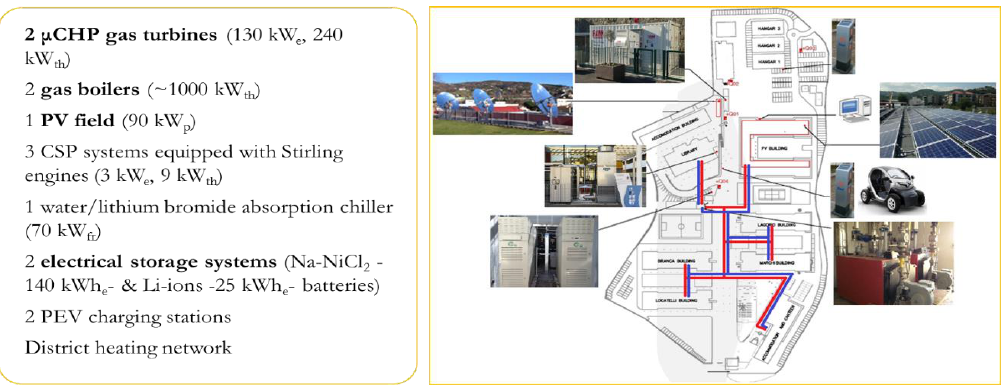
Figure 2. Monitoring of the Savona Campus.